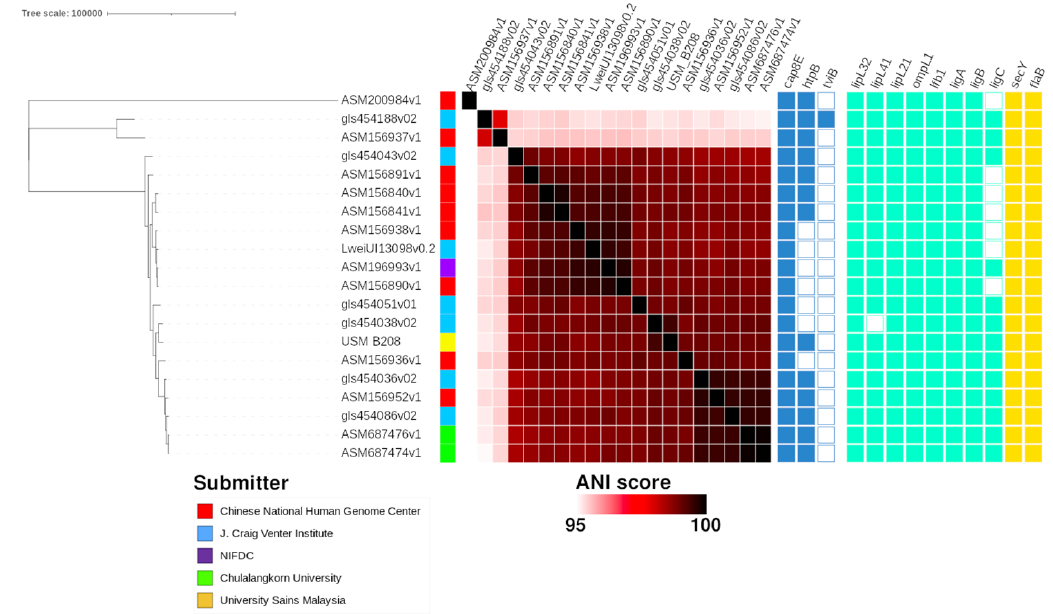
Figure 1. Phylogenomic tree of B208 genome against other L. weilii genomes. Metadata